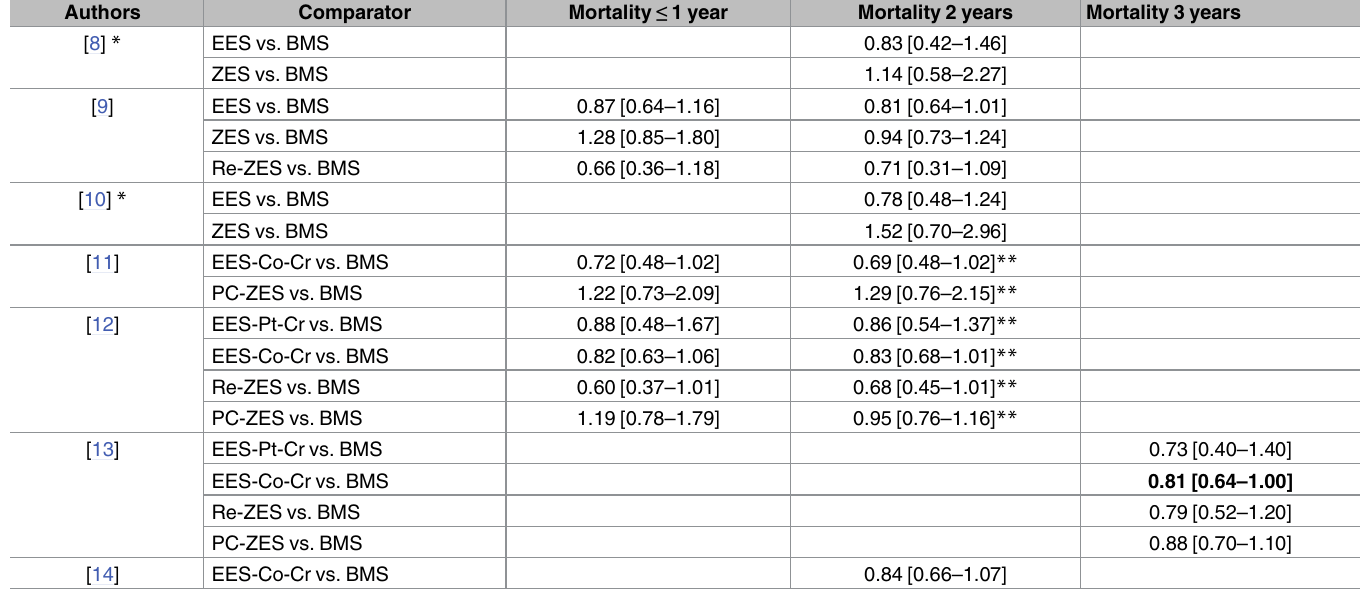
Table 3. Rate ratio of mortality (all causes).